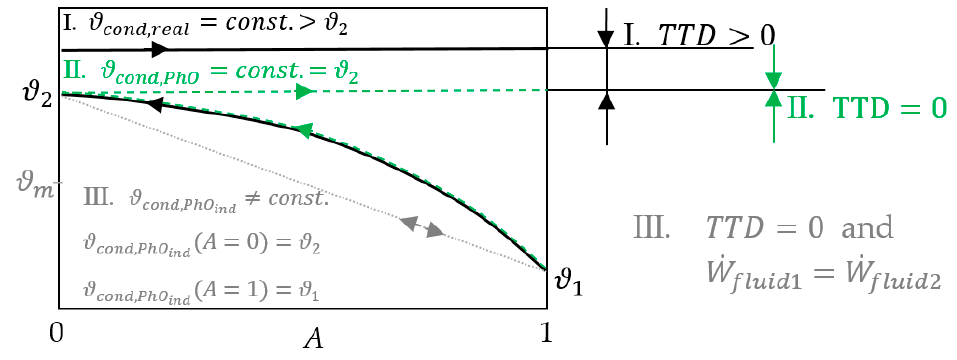
Figure 10. Temperature profile of the heat transfer in the condenser of the HP (real vs. PhO , PhO ind ).